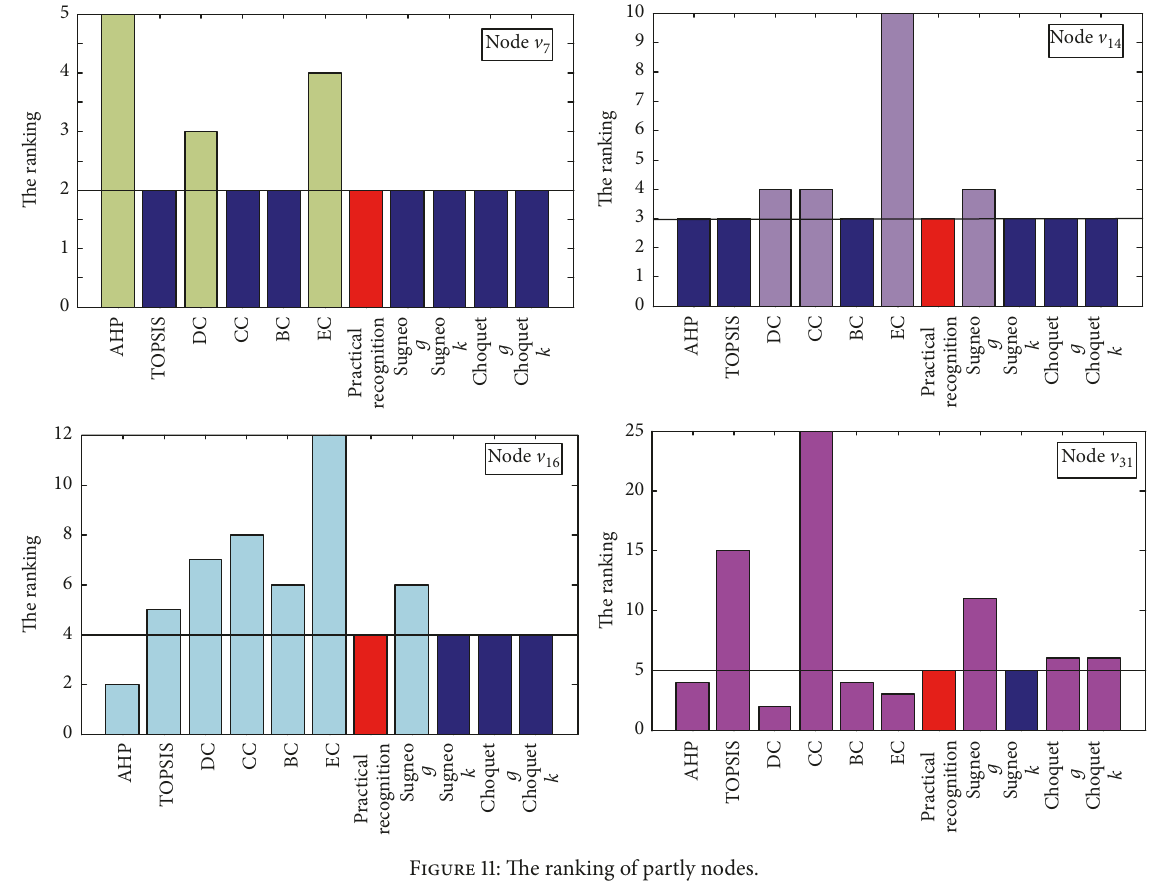
Figure 11: The ranking of partly nodes.